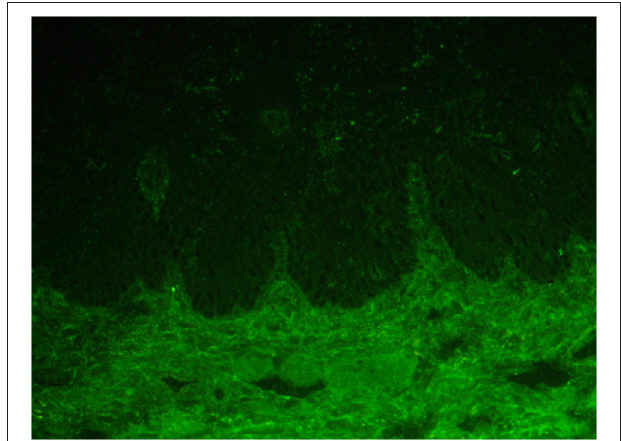
FIGURE 2 | Indirect immunofluorescence of the frozen serum of the patient for IgG, IgA, and C3 was all negative.